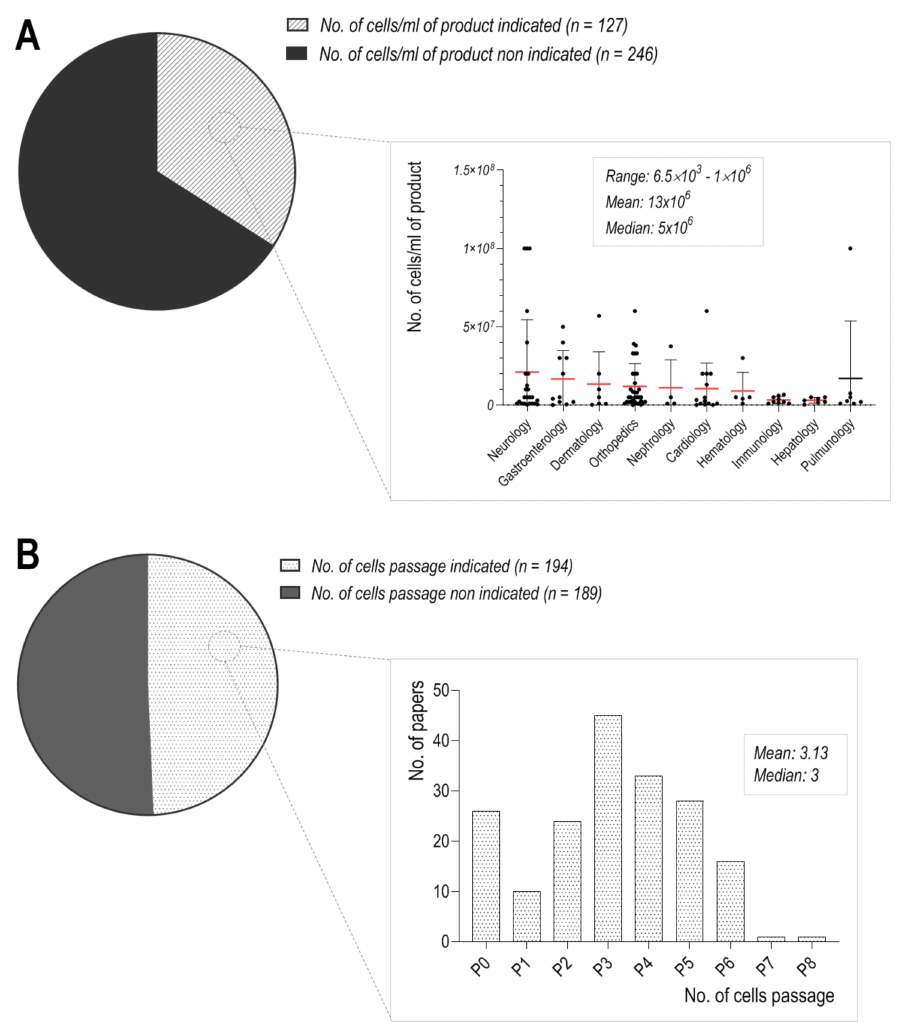
Figure 2. Summary of the results from the literature search. ( A ) The number of cells per milliliter of product, ( B ) Passage number of the MSCs used as a medicinal